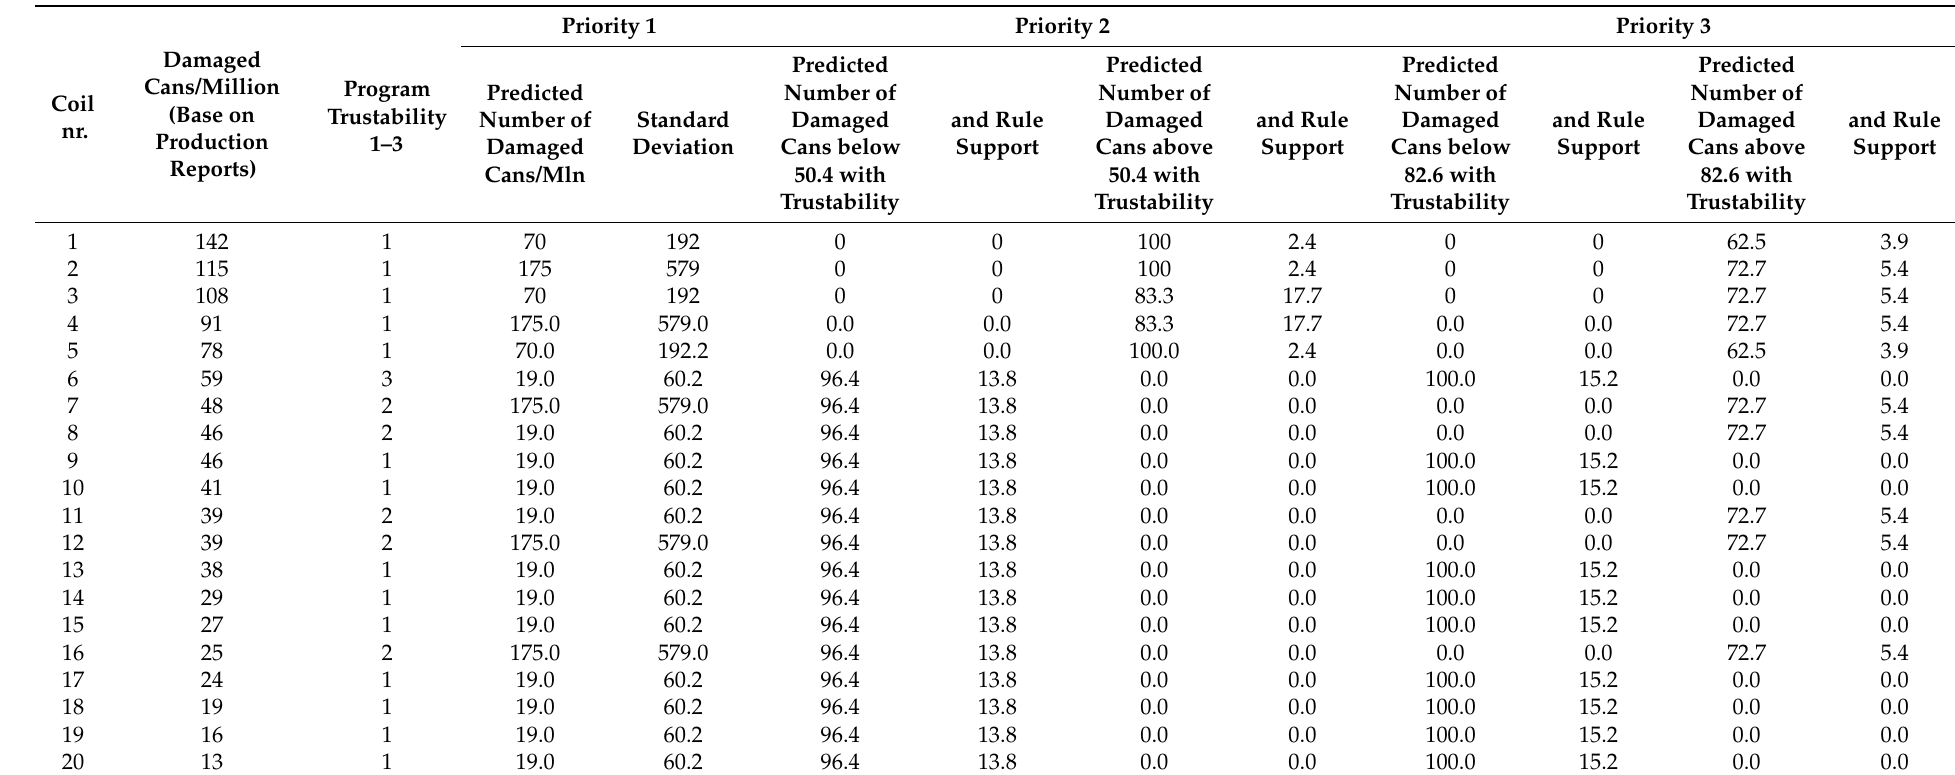
Table 6. Comparison of the predicted number of damaged cans with the actual